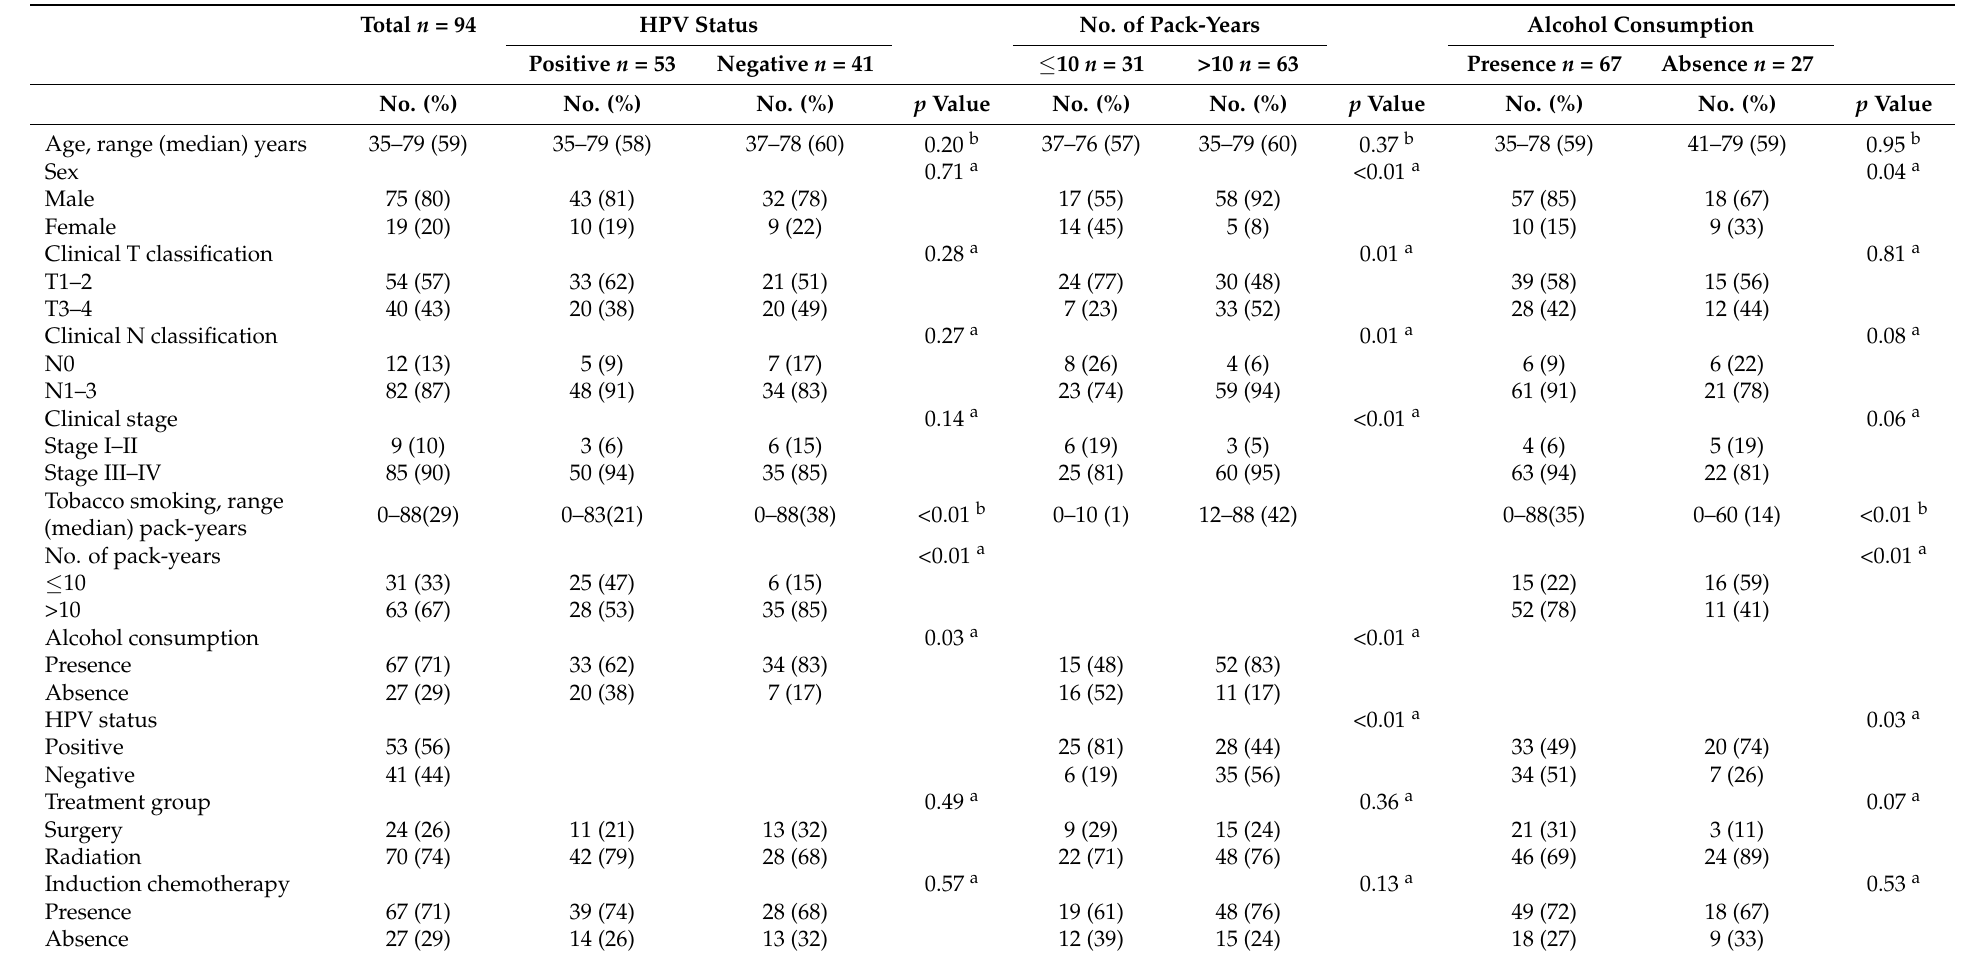
Table 3. Clinical